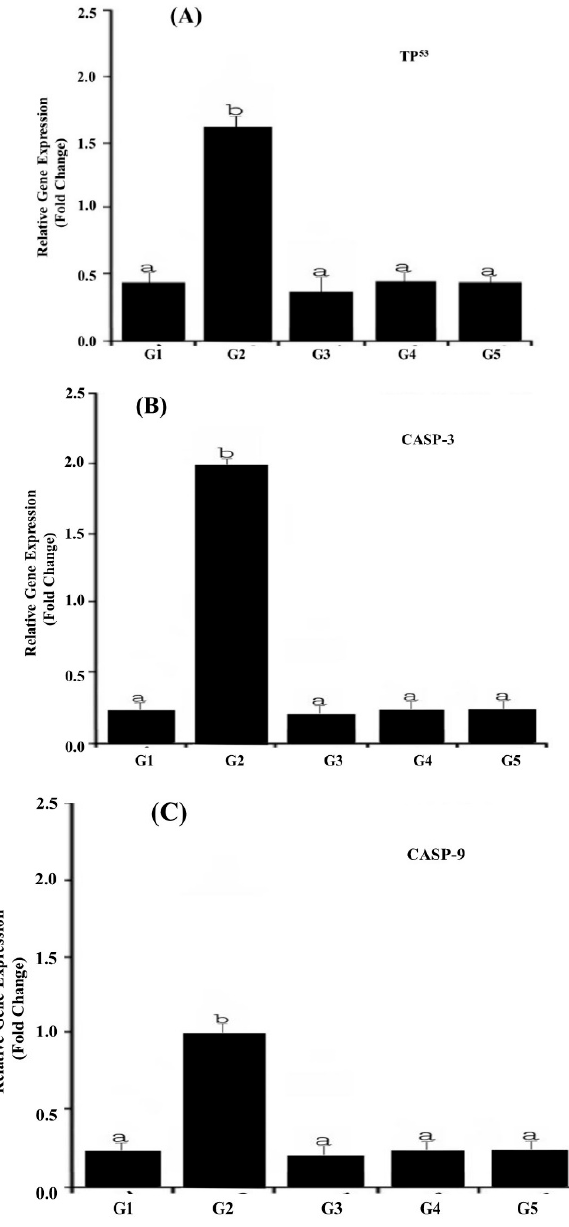
Figure 2. LightCycler ® 480 real-time PCR analysis of apoptosis-related genes in TZ-ingested rats and Nano-CUR ingested rats. The PCR analysis was performed using isolated and reverse transcribed RNA with primers listed in Table 4. CASP-2 methods were applied for relative expression determination using PCR e ffi ciencies, which were determined with the standard curve of each run. The data point denotes the results obtained from three individual batches of cDNA made for each stage or tissue ( A ) TP 53 gene expressions, ( B ) CASP-3 gene expression, and ( C ) CASP-9 gene expression of target genes, which were normalized to the reference glyceraldehyde-3-phosphate dehydrogenase (GAPDH) gene and indicated as mean ± S.E. The di ff erent alphabet letters specify di ff erent mean values at p < 0.05 by a paired Student t -test.